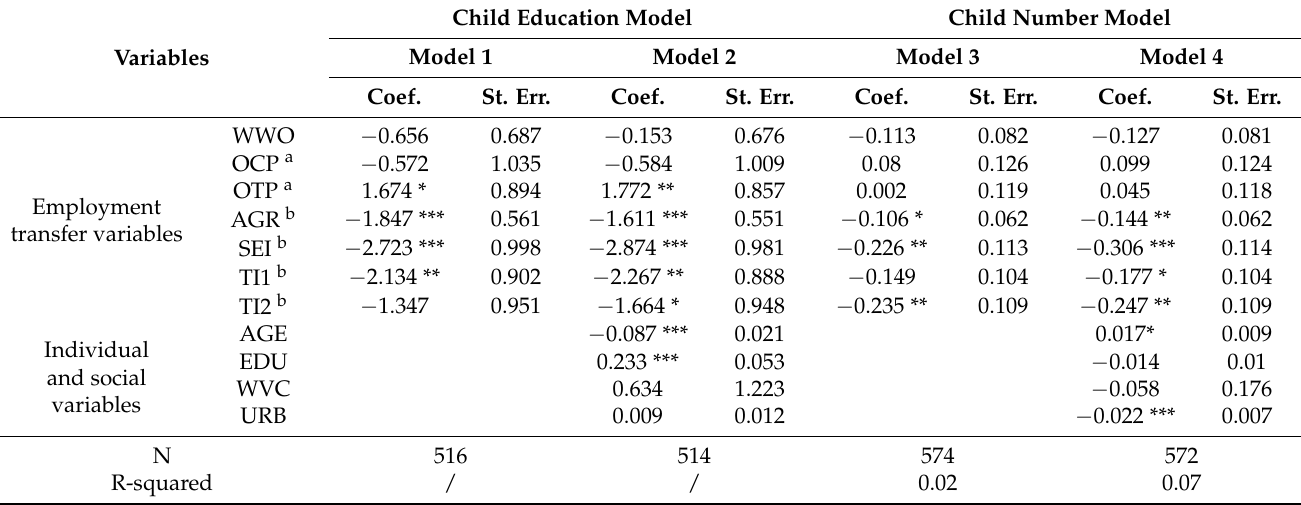
Table 4. Panel regression model of children’s education